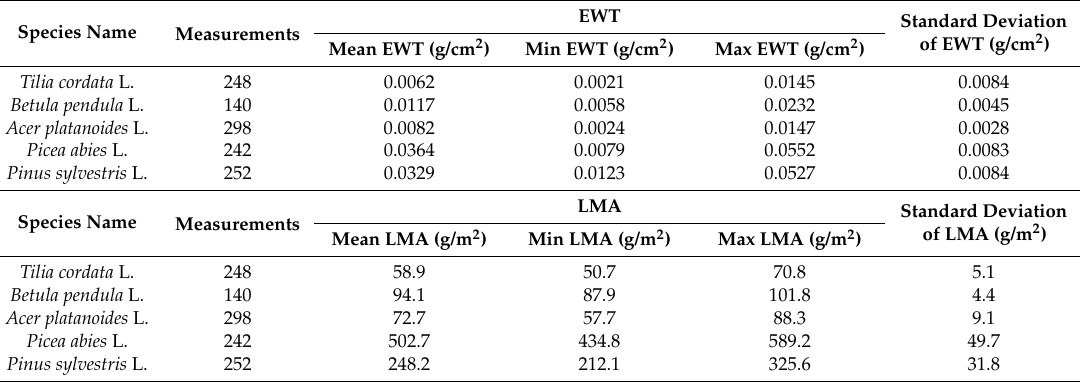
Table 1. A summary of the statistics of equivalent water thickness (EWT; g/cm 2 ) and leaf mass per unit area (LMA; g/cm 2 ) of the samples from all the